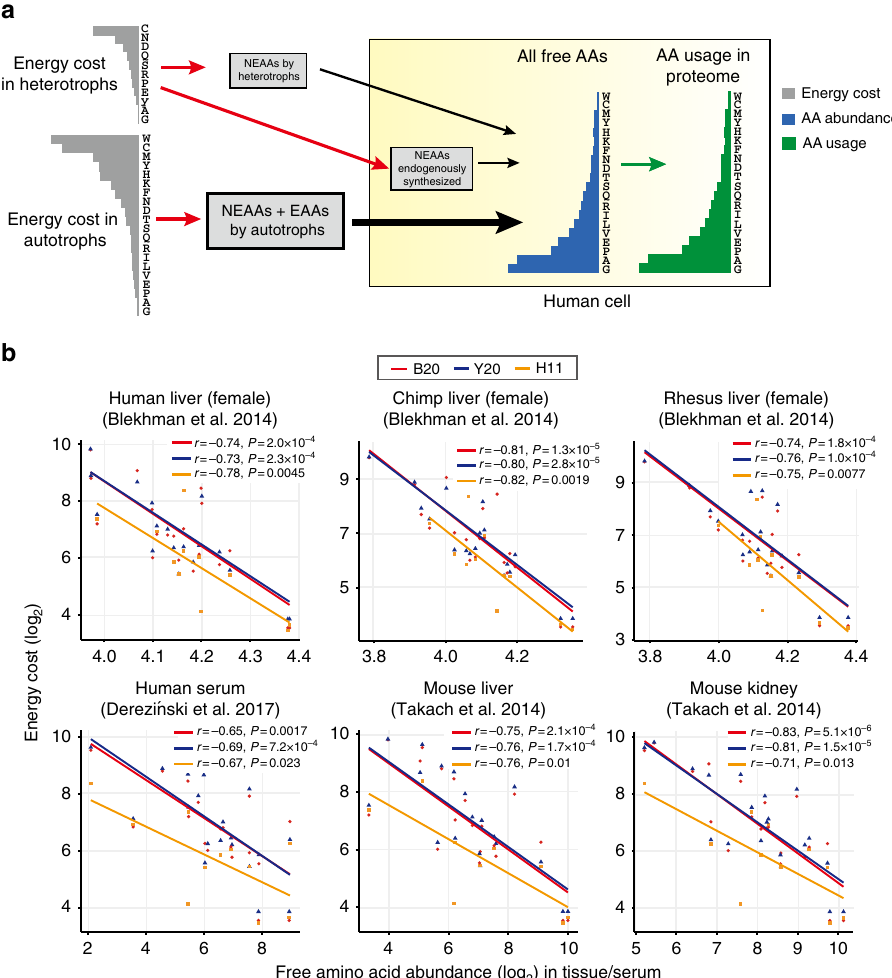
Fig. 2 Biosynthetic cost of AAs constrains their usage in mammalian proteomes. a A model that explains anticorrelation between the usage of AAs in human proteomes and their cost in autotrophs (B20 or Y20) and heterotrophs (H11). Free AA pool in human cells comes from two sources: (1) NEAAs that are endogenously synthesized in human or other animal cells, which are constrained by H11 cost metric; and (2) AAs ultimately taken from autotrophs, which are constrained by B20 or Y20 cost metric. As a result, the total free AAs show anticorrelation with cost in heterotrophs (H11) or cost in autotrophs (B20 or Y20). Bioavailability of free AAs further shapes AA usage in human proteomes by optimizing compositions of protein sequences and expression levels of genes during evolution. b The relationship between the biosynthetic cost of AAs (B20, Y20, H11) and experimentally measured in vivo concentration of free AAs in mammalian